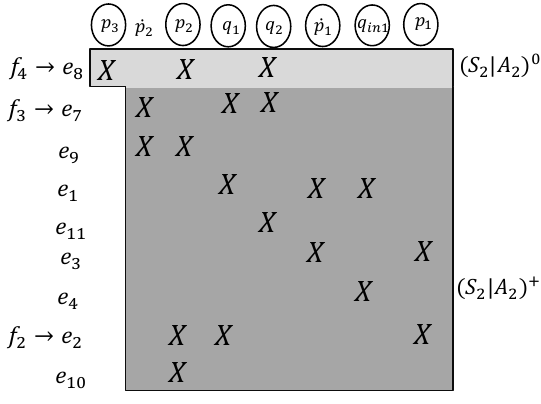
Figure 7. DM decomposition of ( S 2 | A 2 ) .